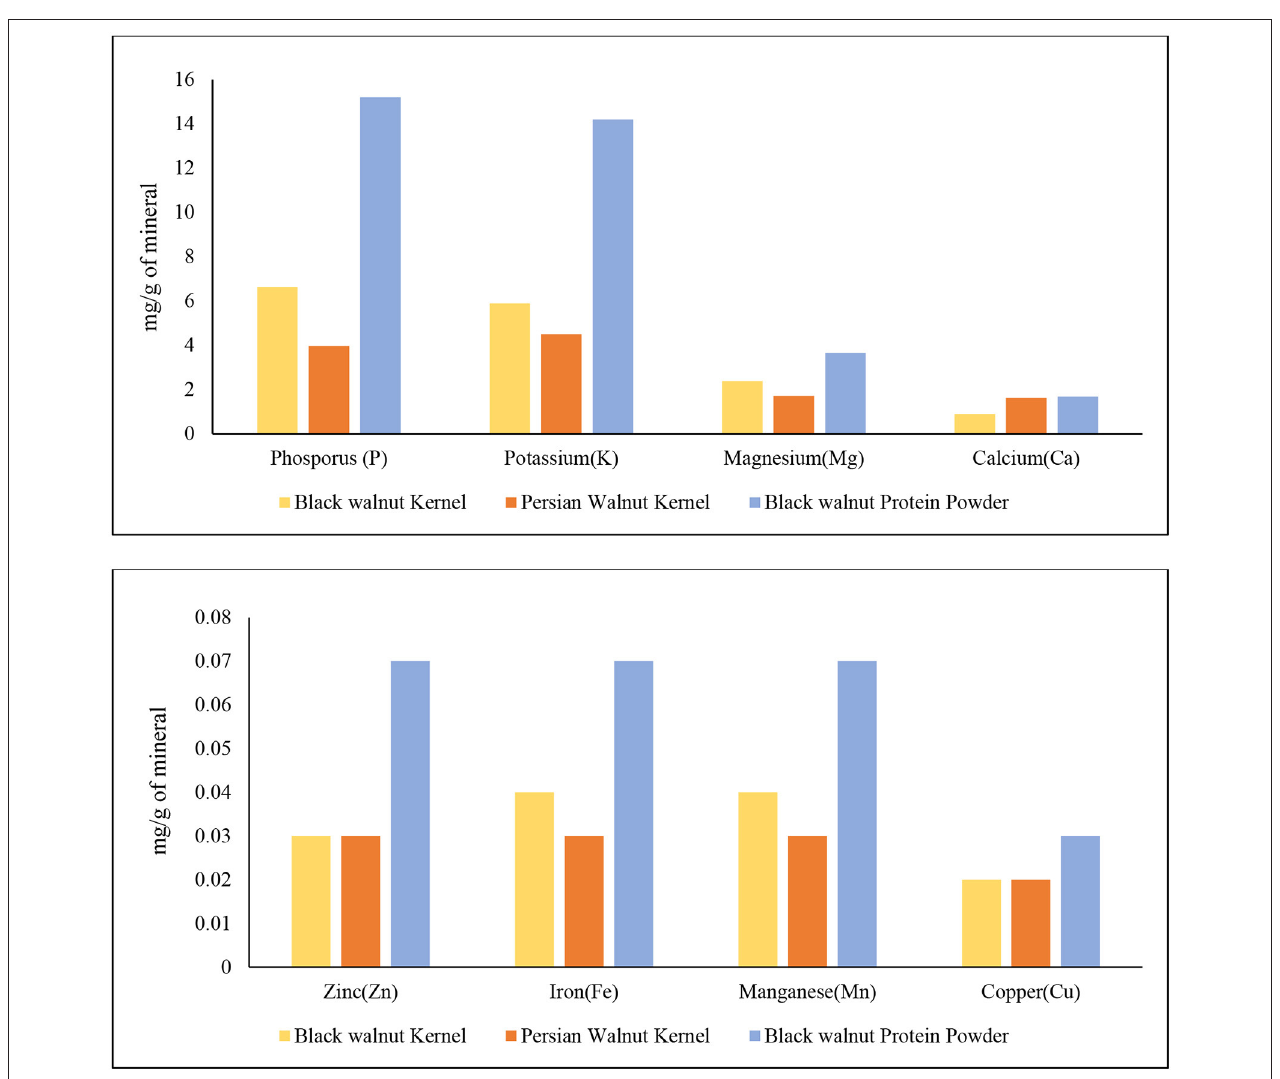
FIGURE 4 | Mineral analysis of Black walnut kernel, Persian walnut, and Black walnut protein powder